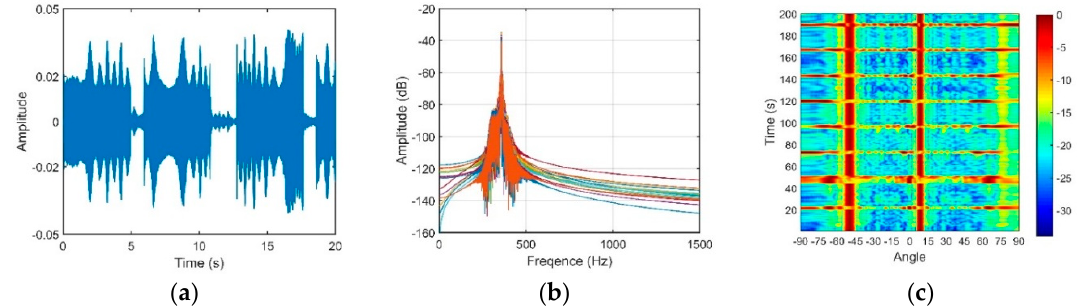
Figure 21. ( a ) Signal waveform; ( b ) Signal frequency through a narrow bandpass filter; ( c ) Beam output of the signal.